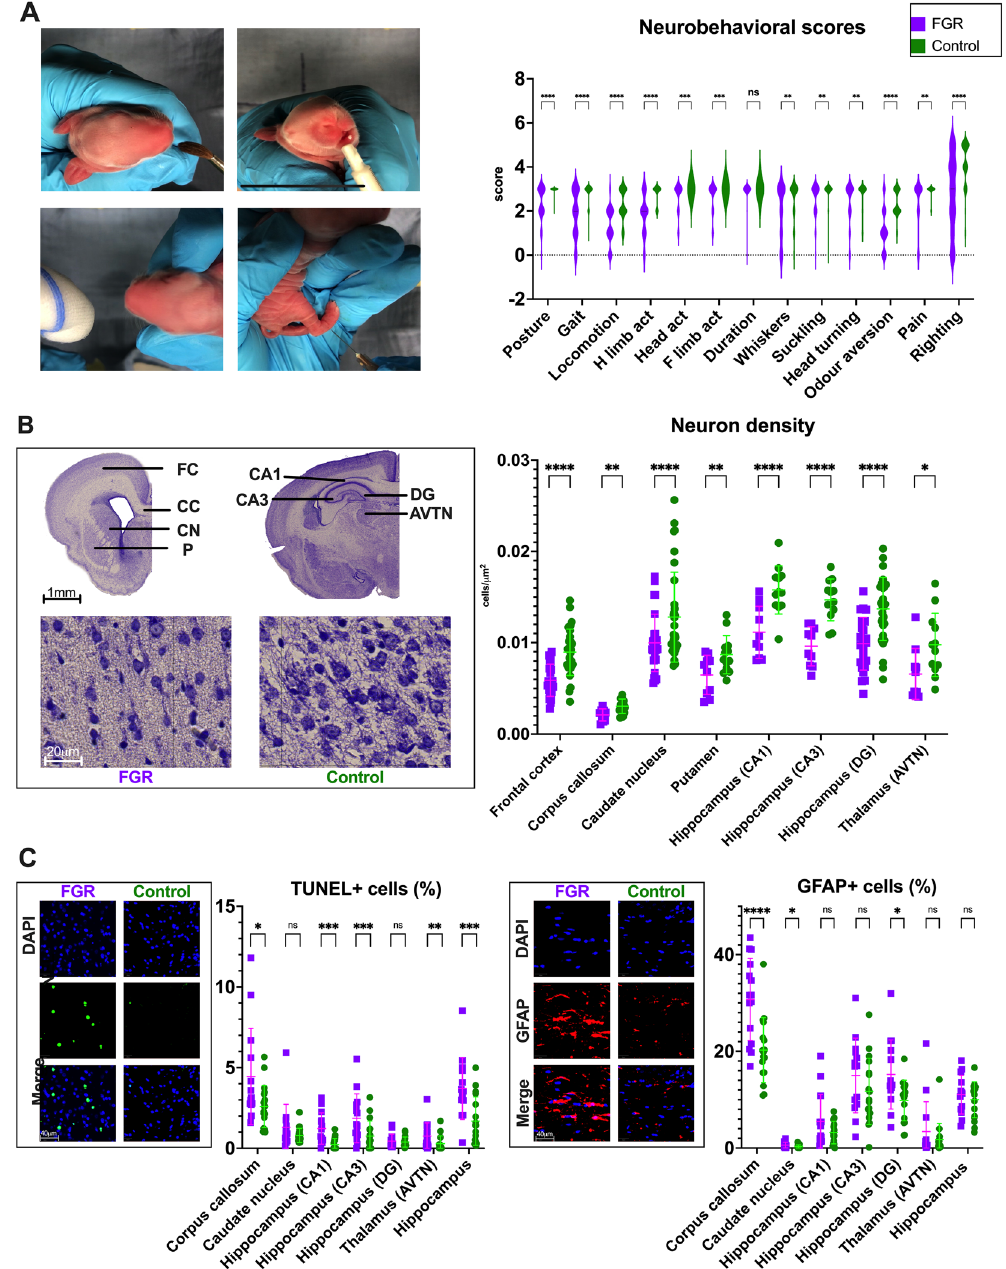
Figure 2. Brain assessment in postnatal day 1 rabbits. ( A ) Neurobehavioral tests (left) and grouped scores (right) from 43 FGR and 61 control subjects from 16 litters. ( B ) Neuron density was assessed in cresyl violet stained slides in the depicted areas (top images). Bottom images show neuron density in the frontal cortex of FGR and control brains. To the right, neuron density from 27 FGR and 29 control subjects from 16 litters. ( C ) Representative images of apoptosis (TUNEL), and astrogliosis (GFAP) in hippocampus and corpus callosum, respectively. Data from 14 FGR and 19 control subjects from 11 litters. CA1 cornu ammonis 1, CA3 cornu ammonis 3, DG dentate gyrus, AVTN anteroventral thalamic nuclei. Data were analysed using a linear mixed-effects model and displayed as mean ± SD with significance as *0.05 ≥ p > 0.01; **0.01 ≥ p > 0.001.; ***0.001 > p > 0.0001; ****p <